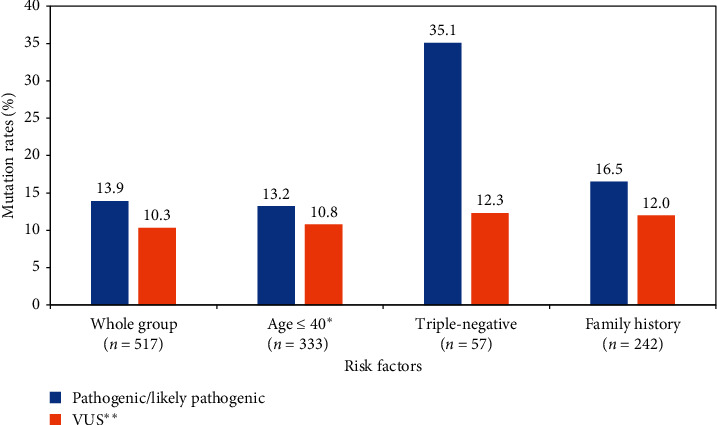

BRCA1and BRCA2 mutation rates by indication.